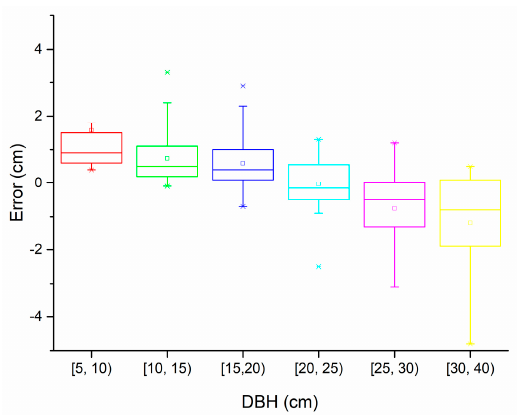
Figure 17. Scatter plot of estimated DBH values.